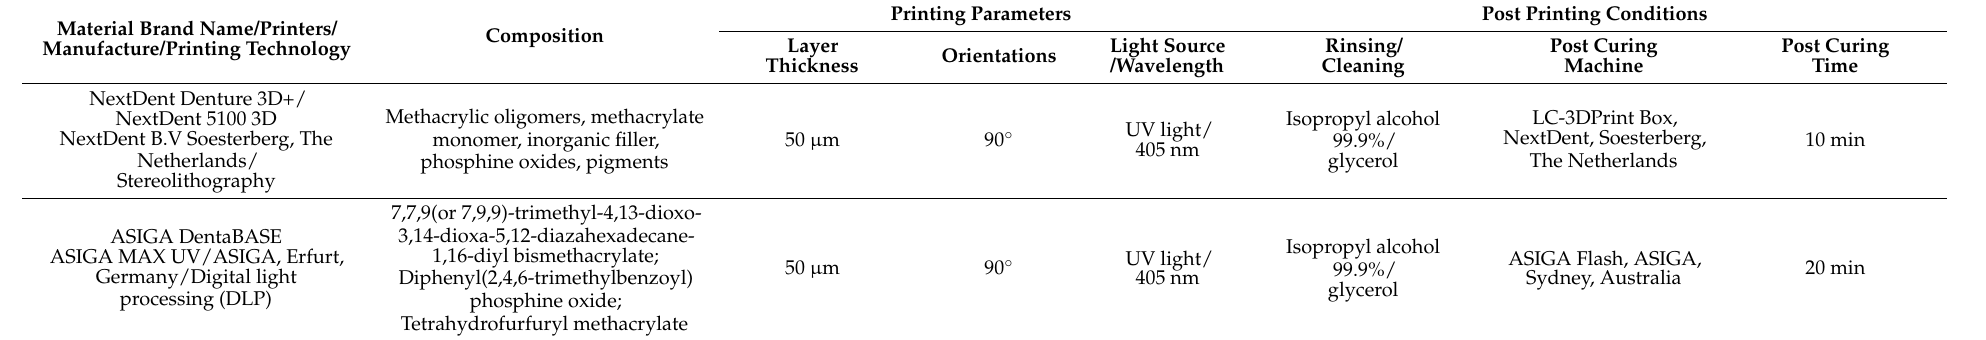
Table 1. Materials and equipment used in the study.